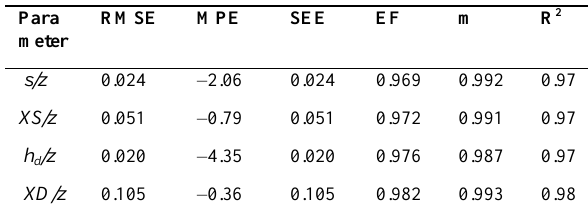
Table 4. . Error function of GP model against experimental